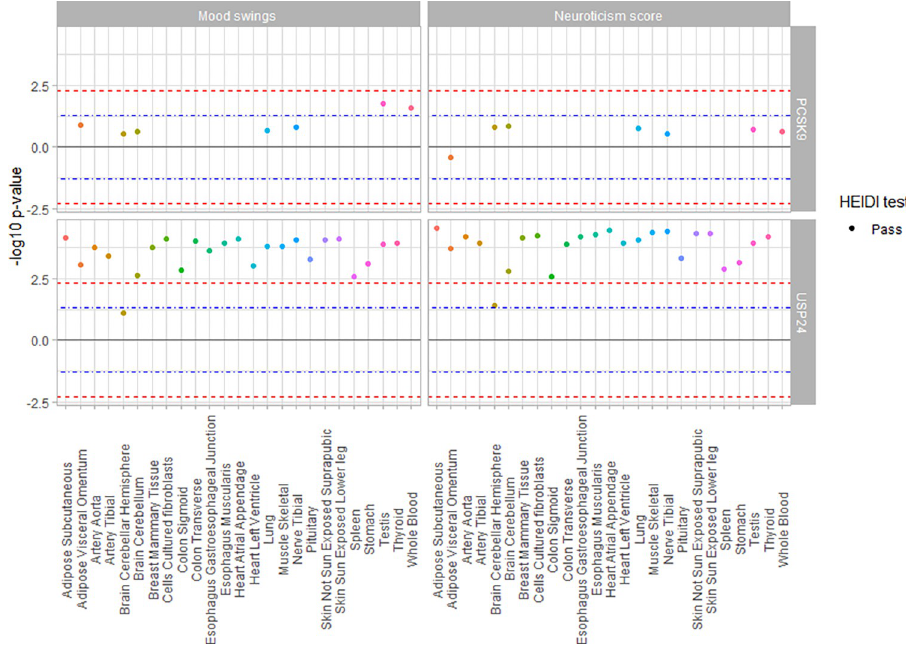
Fig 1. MR association of PCSK9 and USP24 gene-expression levels with phenotypes of interest. The Y-axis represents the -log 10 p-value of the MR association, while the direction signifies the direction of effect of gene- expression reduction, which serves as a proxy for PCSK9i. SMR multi-SNP analyses association of the available 25 tissues for PCSK9 and USP24 gene-expression in GTEx v8 for outcomes Mood swings (A) and Neuroticism score (B). (C) MR (IVW) for PCSK9 and USP24 gene-expression with combined eQTL estimates from all available tissues in GTEx v8. The blue and red lines signify p-value of 0.05 and Bonferroni-corrected threshold for 5 traits per gene of 0.005, respectively.